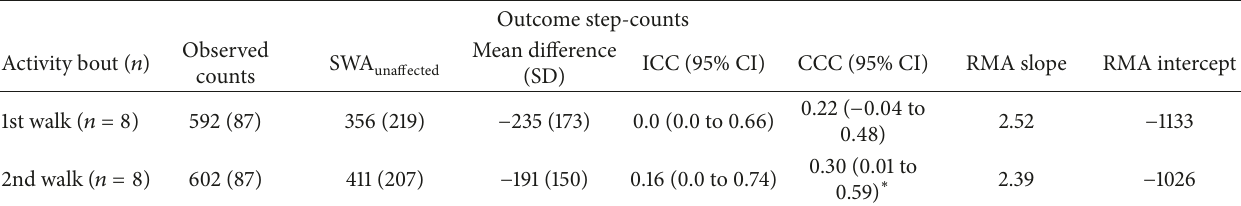
Table 3: Step-counts and agreement between observed count and SWA unaffected .